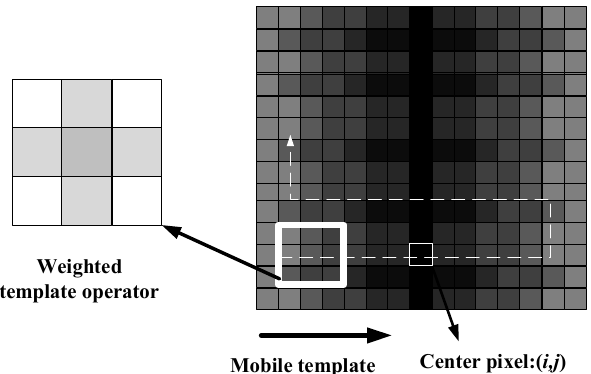
Figure 5. Schematic of weighted template operator for image enhancement.